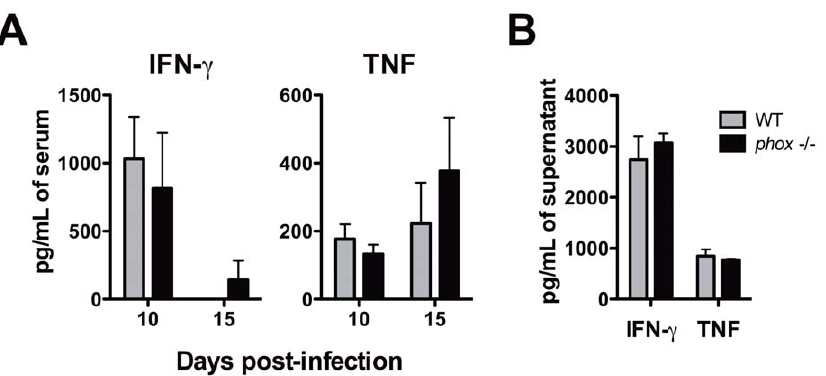
Figure 3. WT and phox KO mice produce similar levels of IFN- c and TNF. (A) WT and phox KO animals infected with T. cruzi were bled at days 10 and 15 post-infection for cytokine measurements. (B) Infected mice were sacrificed at 10 days post-infection and spleen cells isolated and cultured for 72 hours, when supernatants were harvested. IFN- c and TNF were measured by ELISA as described in material and methods. Bars represent mean 6 SE of at least 4 animals per group. Experiment was repeated once with similar results.